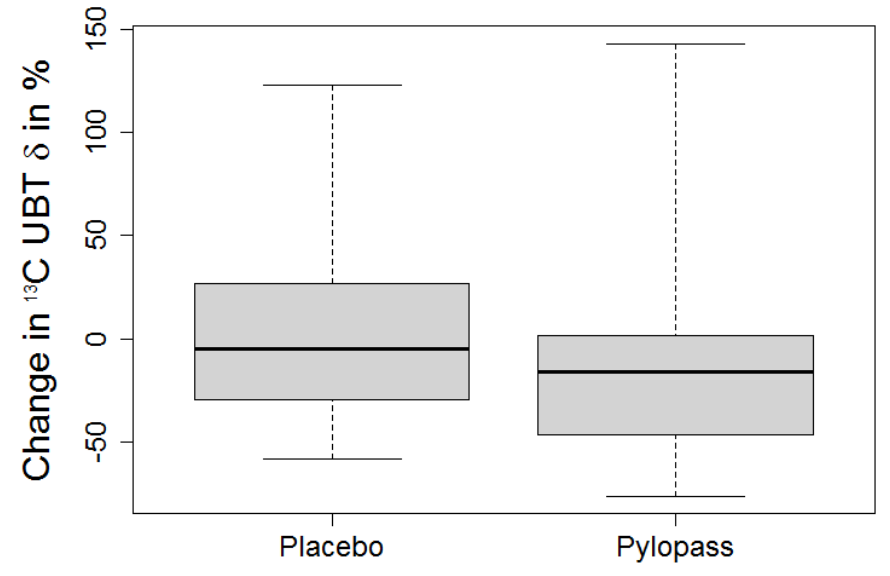
Figure 2. Percentage of change of 13C UBT after placebo and